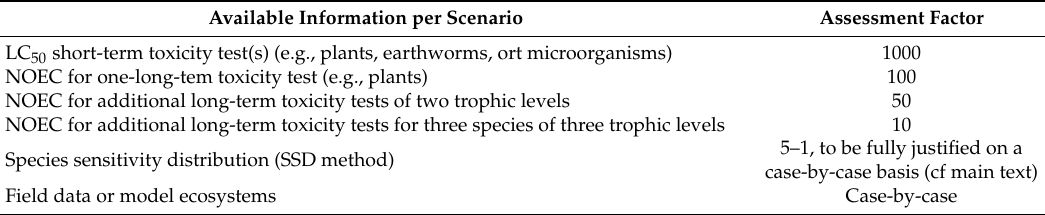
Table 2. Example of Assessment factors for chemicals currently used in REACH (EU) for deriving Predicted No Effect Concentrations (PNEC) for assessing the Soil compartment, see https://echa. europa.eu/documents/10162/13632/information_requirements_r10_en.pdf, Table R.10-10 f. It is unknown whether these also will be adequate for